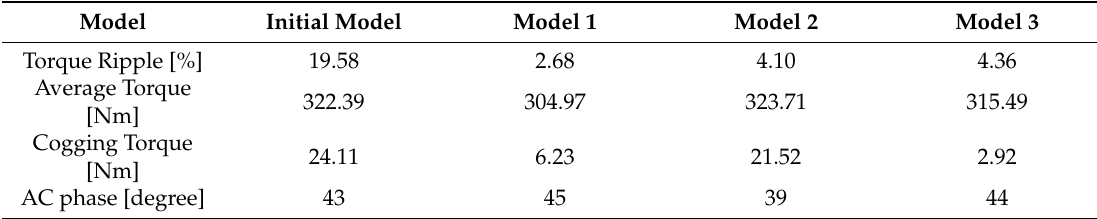
Table 6. Performance comparison of initial and optimal models.